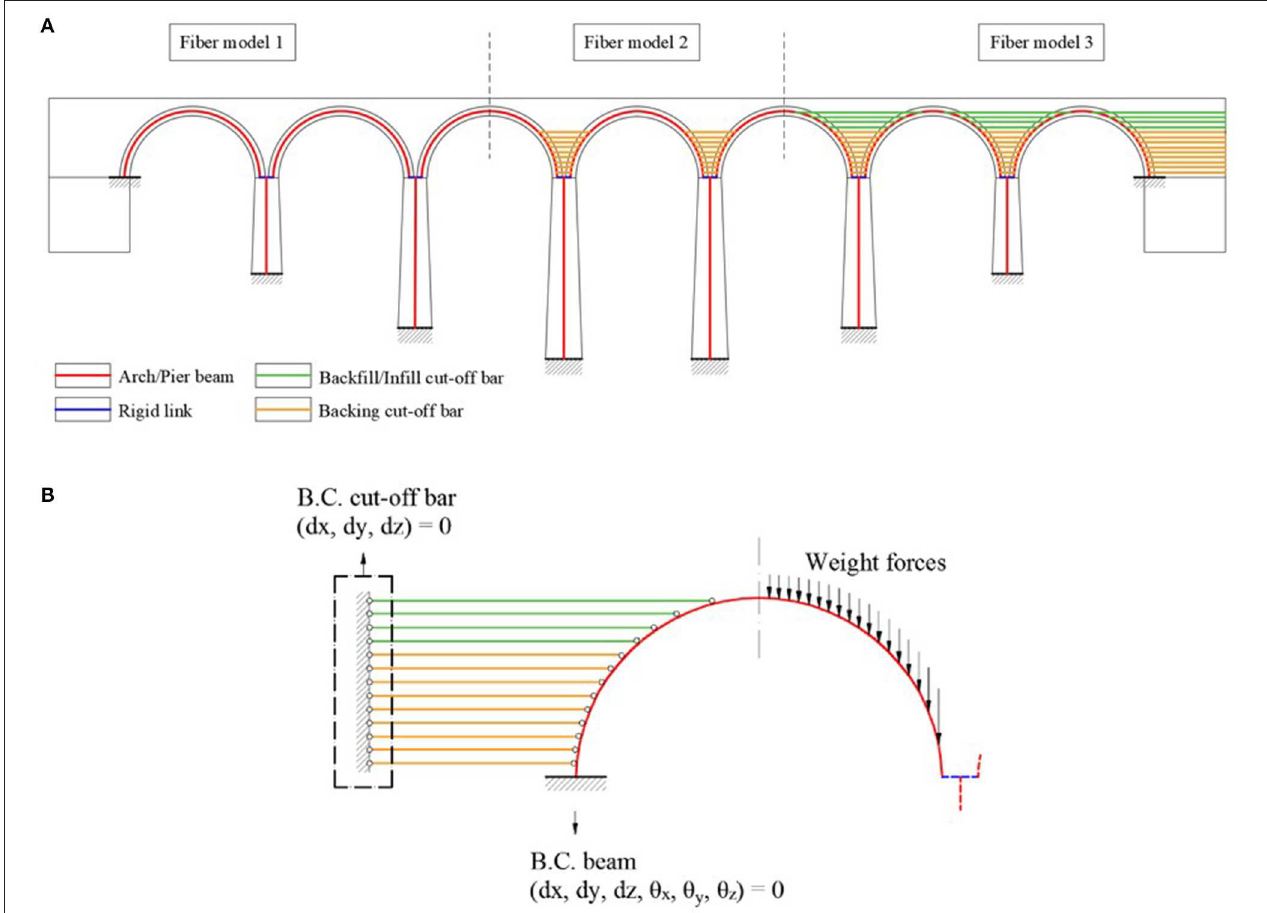
FIGURE 6 | FEM modeling of the arch bridge under study. (A) Schematic representation of the fiber model considered. (B) Detailing of the constraint and loading conditions considered for the fiber-beam model of the bridge.